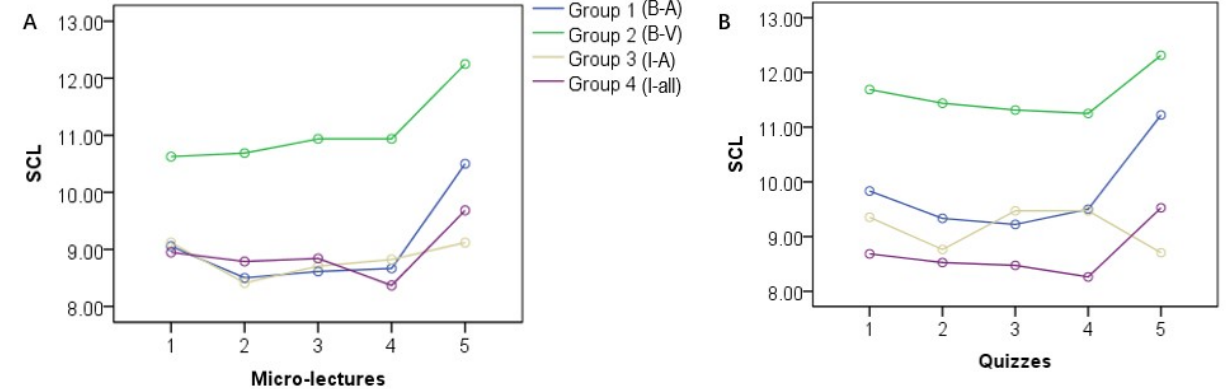
Figure 3. SCL during the five micro-lectures ( A ) and five quizzes ( B